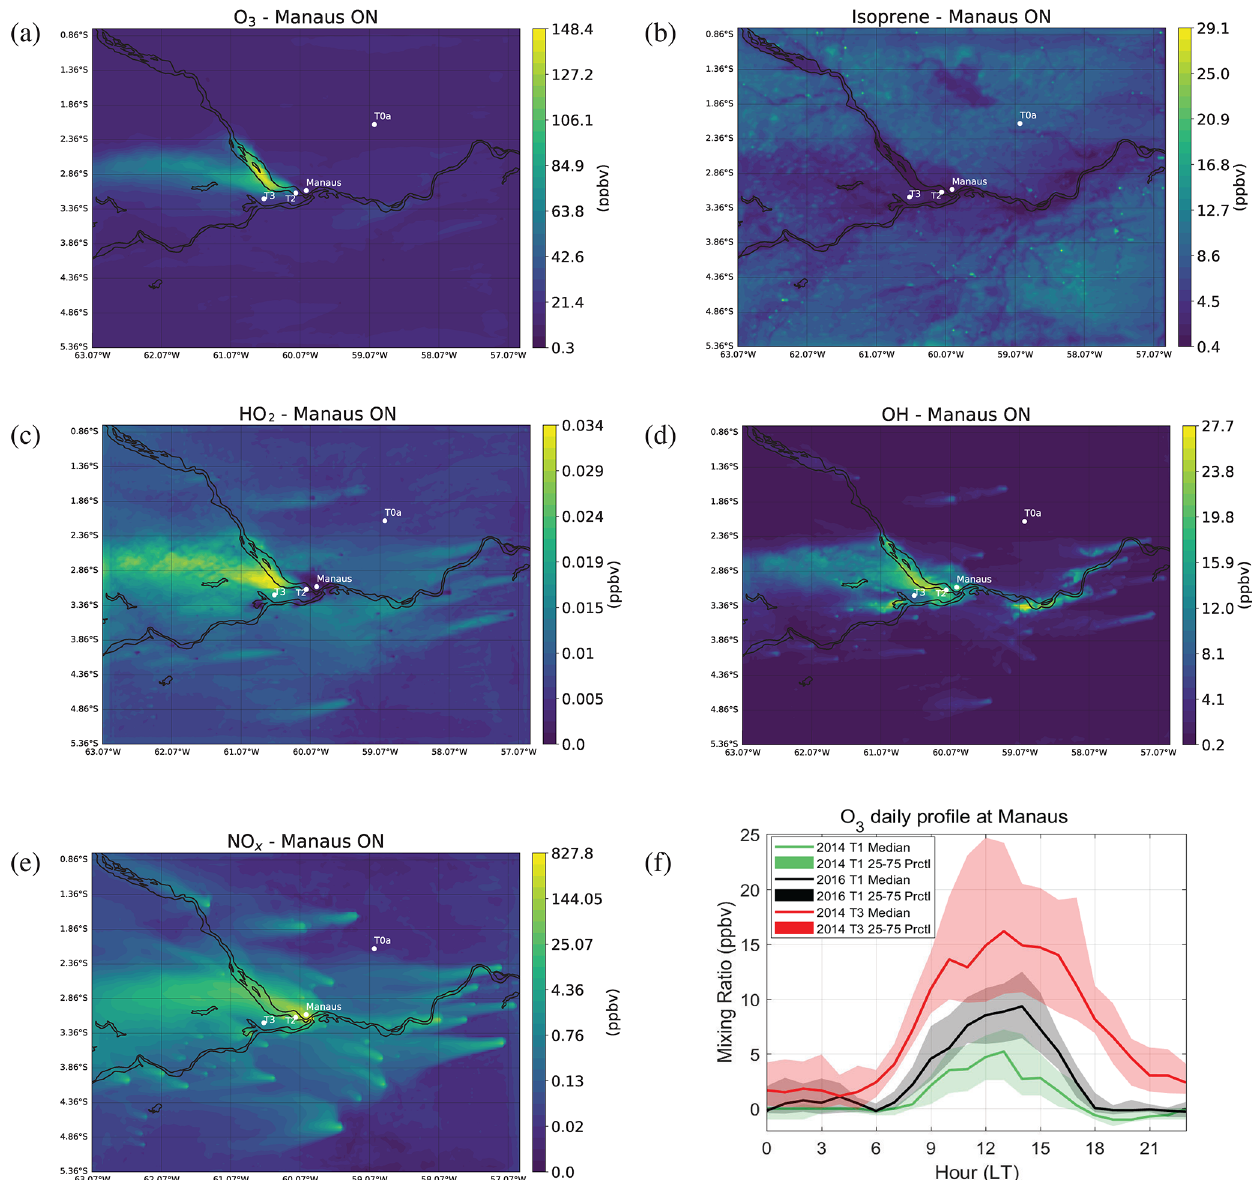
Figure 4. Temporal mean (06:00 to 15:00LT; 13 March) spatial distribution of simulated surface level concentrations of (a) ozone (O 3 ), (b) isoprene, (c) peroxy radicals (HO 2 ), (d) hydroxyl radicals (OH), (e) nitrogen oxides (NO x ) and (f) daily median O 3 profile for the month of March (wet season) at the T1 site during 2014 (green line), 2016 (black line) and at the T3 site during 2014 (red line). The red, gray and green shaded areas show the 25th to 75th percentiles (Prctl) of the respective median